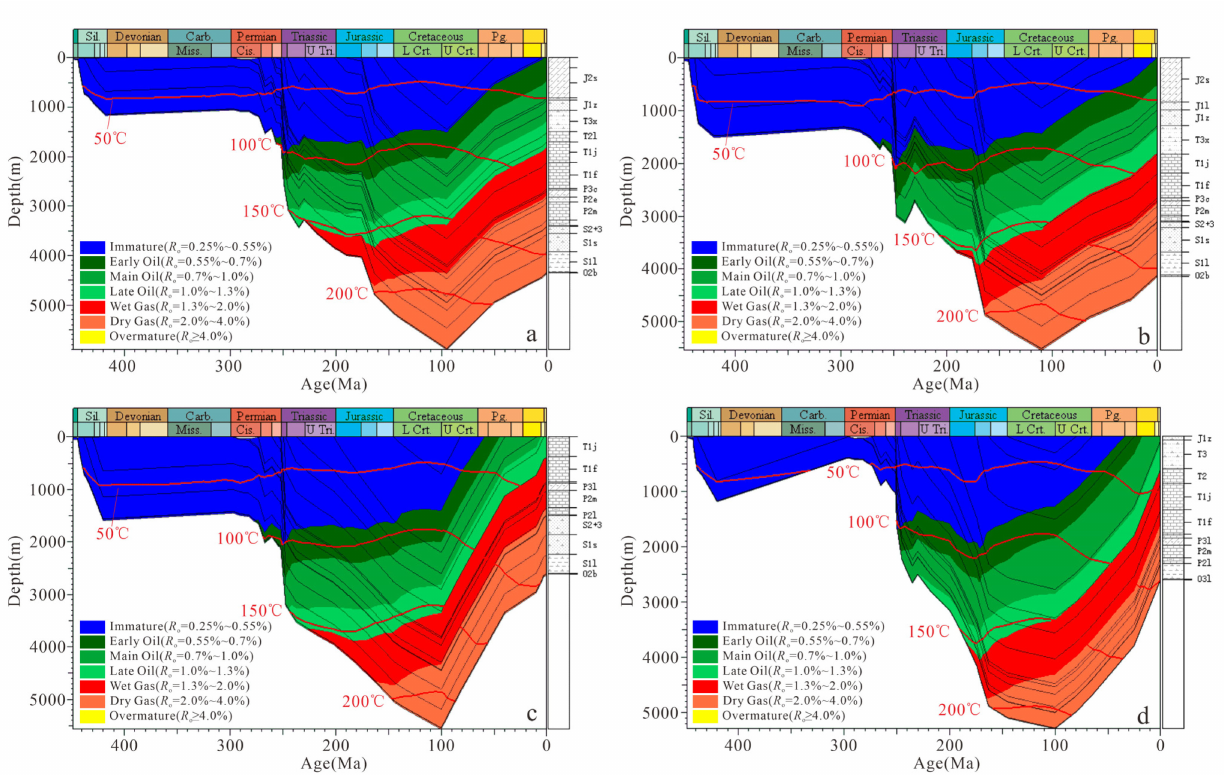
Figure 10. The burial, thermal history and maturation of the Wufeng–Longmaxi Formations in well N222 ( a ), Y101H4-4 ( b ), N213 ( c ) and W202 ( d